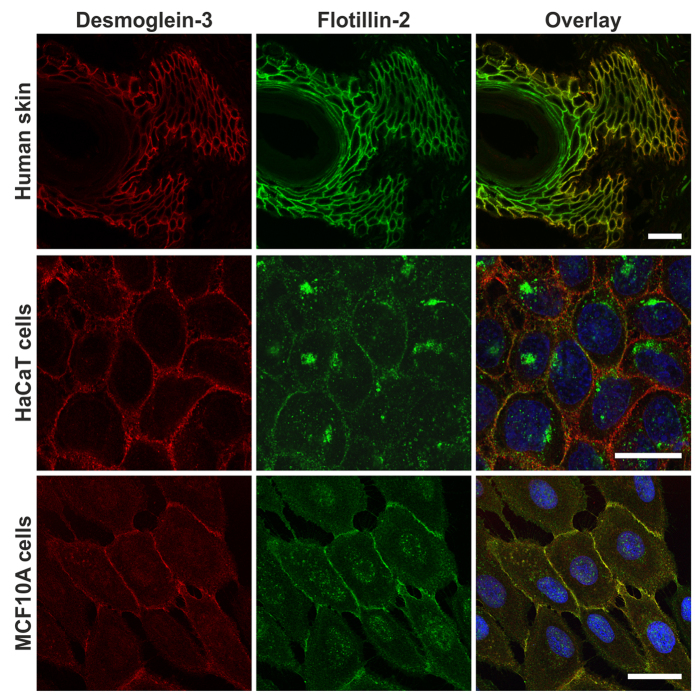
Desmoglein-3 and flotillin-2 colocalise in human epidermis and human epithelial cell lines.Human skin cryosections, HaCaT and MCF10A cells were immunostained for Dsg3 (red) and flotillin-2 (green). In human epidermis, flotillin-2 is expressed throughout the epidermal layer and colocalises with Dsg3 in keratinocytes of the stratum basale and suprabasale. In HaCaT keratinocytes, flotillin-2 is localised at the cell membrane and in intracellular vesicular structures. Dsg3 is localised at the plasma membrane where it colocalises with flotillin-2. In MCF10A mammary epithelial cells, flotillin-2 and Dsg3 show a more profound colocalisation at the sites of cell-cell contact. The cell lines were grown on glass coverslips for at least 3 days. Scale bar: 20 μm.